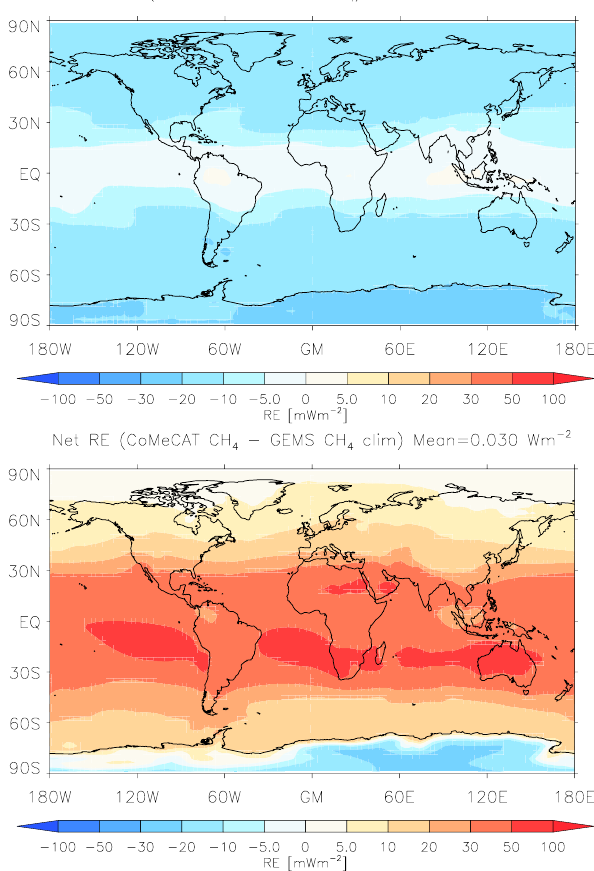
Fig. 12. Annually averaged net radiative forcing (mWm − 2 ) in- duced by using the CoMeCAT CH 4 (a) instead of a default constant value of 1.80ppmv in the Edwards–Slingo (E-S) radiation model (upper panel) and (b) instead of the GEMS climatology for CH 4 in the E-S model (bottom panel). See main text (Sect. 6.2) for de- tails about the model runs used for these calculations. In the colour scale, blue is for negative radiative effect (cooling), and red for pos- itive radiative effect (warming).